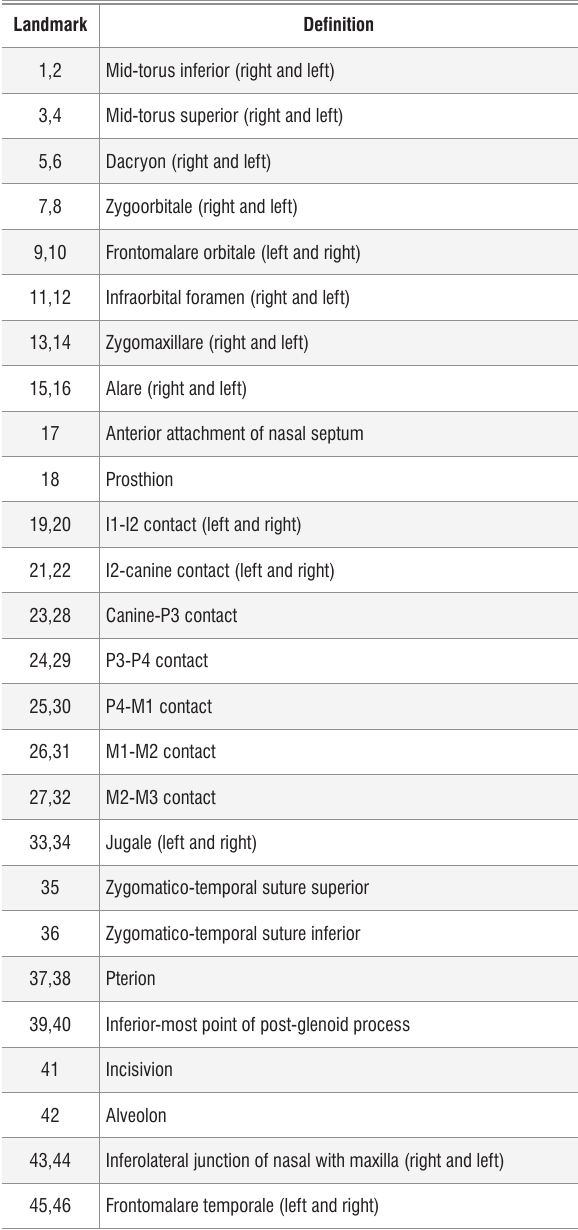
Landmark definitions for the subset of landmarks used in mor- pho metric